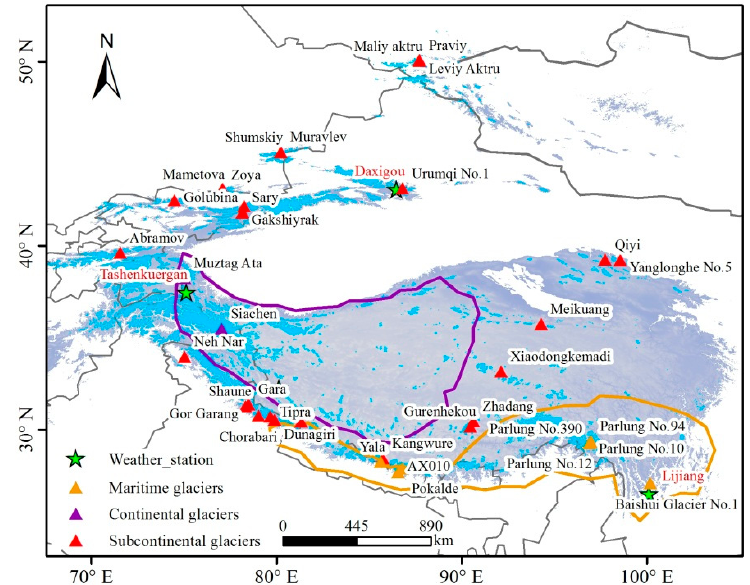
Figure 1. Location of the 45 monitored glaciers in HMA used in this study (triangles) and four national weather stations (green stars). Polygons are enclosing the glaciers of a certain type: maritime type is within orange polygon, continental type within purple, while all outside are subcontinental types. Next to Mametova glacier are seven unmarked glaciers: Ts.Tuyuksu, Igly.Tuyuksu, Molodezhniy, Kara-Batkak, Mayakovskiy, Ordzhonikidze, and Visyachiy; next to Dunagiri glacier is one unmarked glacier: Naimona’nyi; and next to Pokakde glacier is one unmarked glacier: Changmekhangpu.